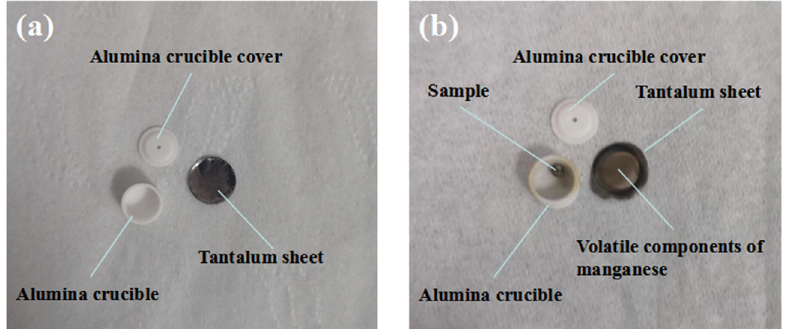
Figure 7: Picture of aluminum oxide crucible before and after thermo gravimetry: ( a ) before thermo gravimetry and ( b ) after thermo